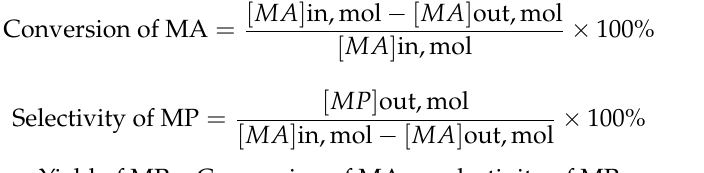
Figure S3. XRD patterns of NiAl 2 O 4 ; Figure S4. H 2 -TPR profiles of Ni 10 Al, Mo 10 Al, Ni 10 Mo 10 Al catalysts; Figure S5. Effect of reduction temperature on the catalytic activity of Ni 10 Mo 10 Al catalyst at the reaction conditions of 100 ◦ C, 1 MPa H 2 , n(H2)/n(MA) = 4 and WHSV =2 h –1 ; Figure S6. TEM images of the used Ni 10 Mo 10 Al catalyst; Table S1. Properties of NiAl 2 O 4 , Ni 10 Mo 10 Al